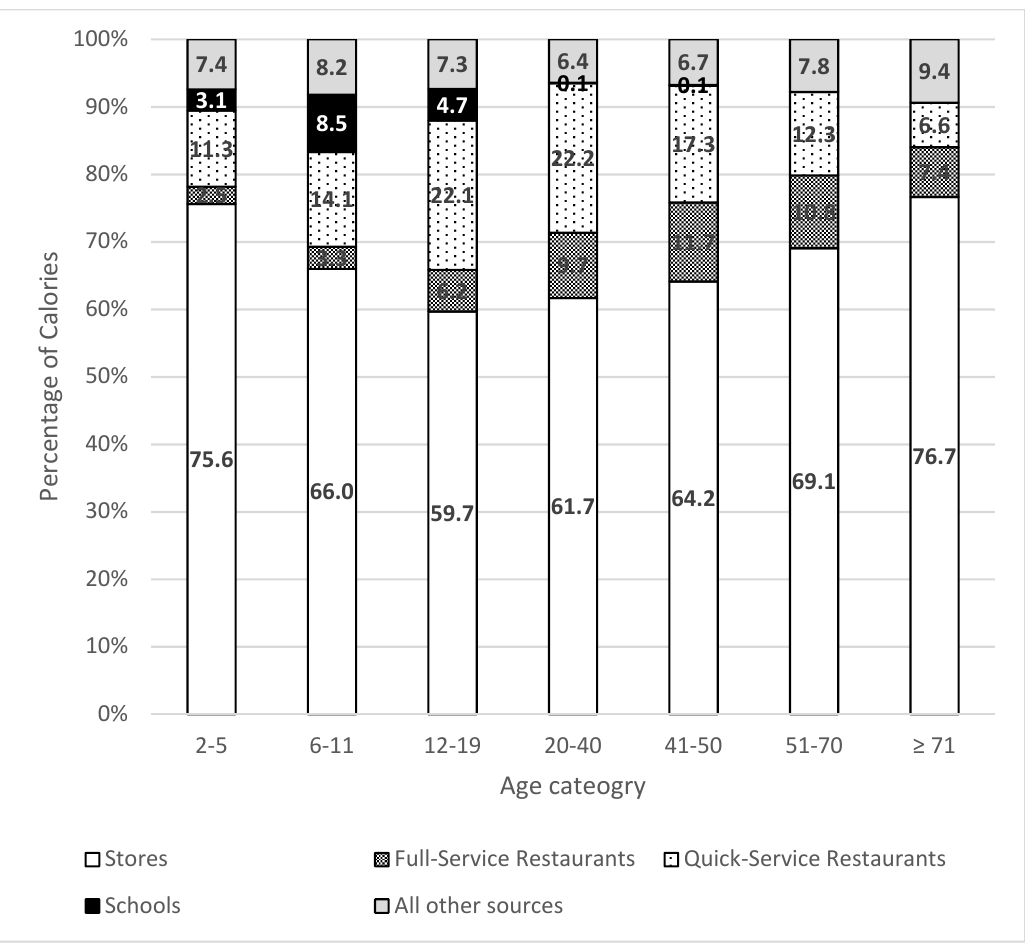
Figure 1. Percentage of calories obtained from each food outlet by age category, NHANES 2017–2018.